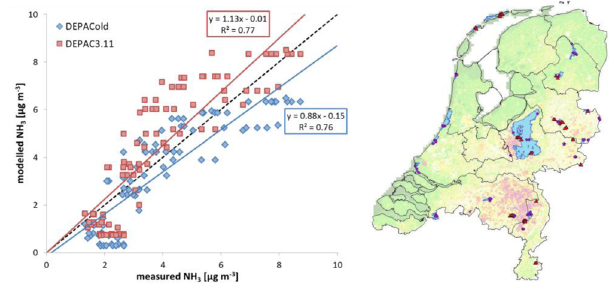
Fig. 8. Comparison of the modeled total ammonia concentrations (sum of ammonia and particulate ammonium modeled with DEPA- Cold (red) and DEPAC3.11 (blue)) with the EMEP measurement stations ( n = 33) in Europe in 2007. The grid resolution of the model results is 0.50 ◦ longitude × 0.25 ◦ latitude ( ∼ 28 × 28km 2 ) .